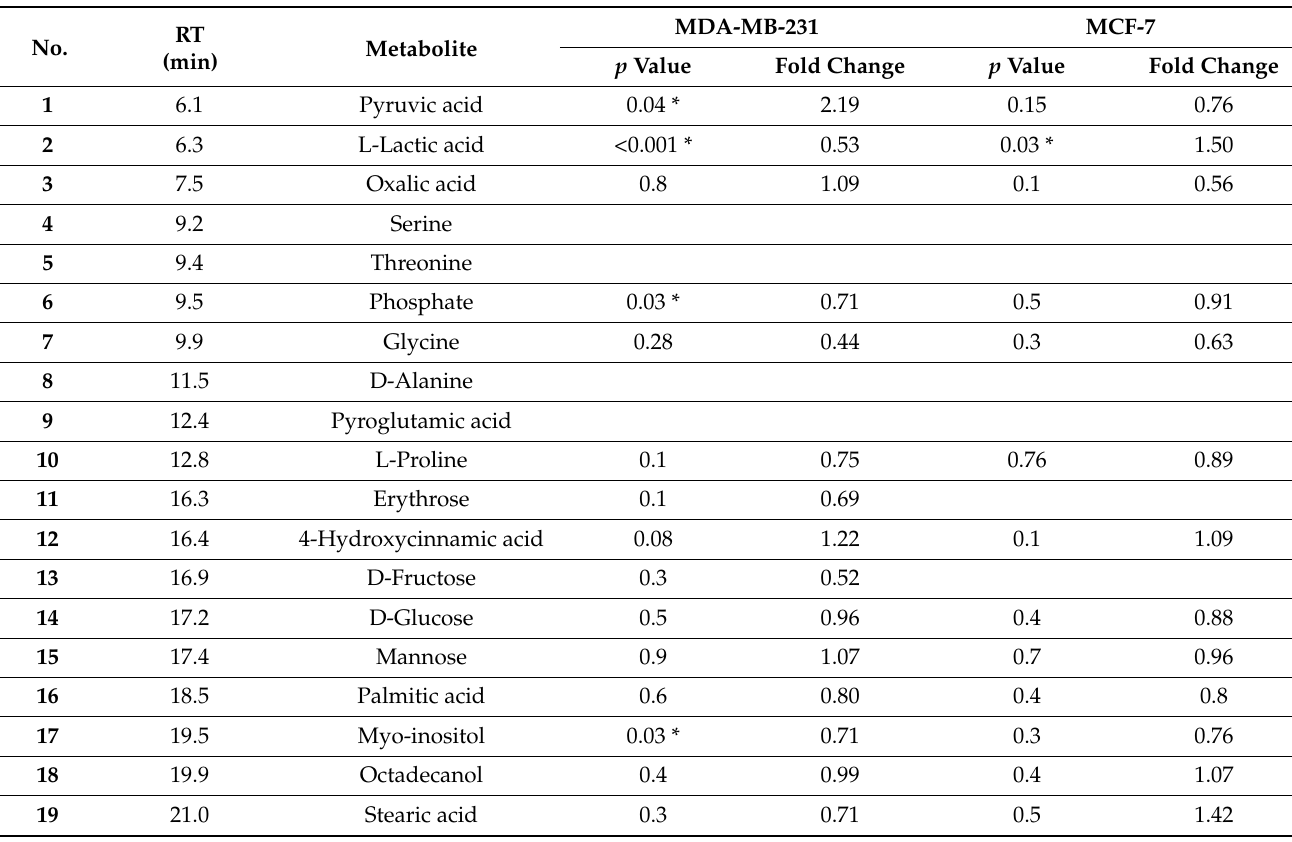
Figure 8. Metabolomic set enrichment analysis of MDA-MB-231 and MCF-7 cells. Notes: Metabo- lomic set enrichment analysis showing the most changed functional metabolism of MDA-MB-231 ( A ) and MCF-7 cell lines ( B ) after treatment with compound 1 in duration of 48 h. Molecular path- ways were ranked according to the probability ( p -value) of finding a particular number of signifi- cantly changed metabolites in the compound list of a certain pathway.